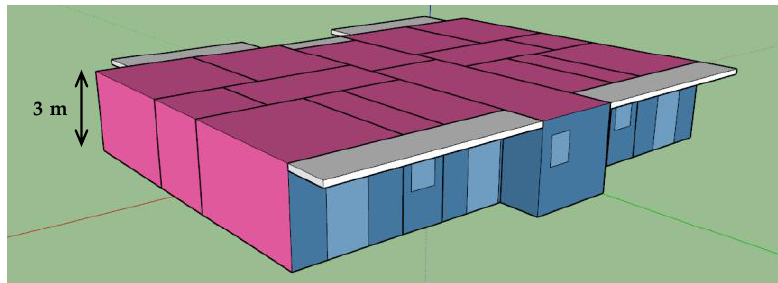
Figure 2. Axonometric view of the thermal model with two apartments per floor (pink surfaces: Adiabatic; blue surfaces: Exterior; white surfaces: Shadings).